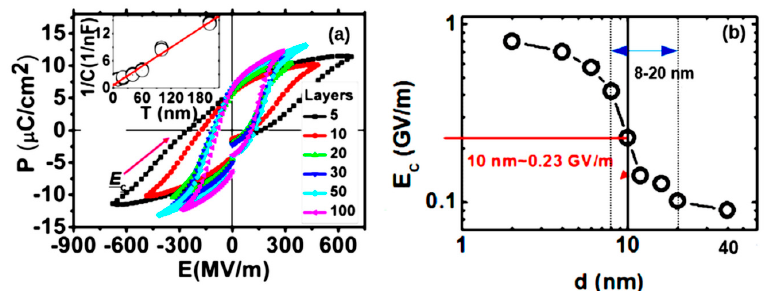
Figure 4. Hysteresis loops of the LB PVDF film [16]: ( a ) with different numbers of monolayers: 5, 10, 20, 30, 50 and 100 (the inset shows the linearity of the reciprocal capacity depending on the thickness); ( b ) E C as a function of the LB thickness of the PVDF film (with the transition region at 8–20 nm). Reproduced with permission from [16]; AIP Publishing, 2014. Another method for obtaining a coercive field is by calculation of hysteresis loops P ( E ) [27,28]. Calculations performed for different numbers of chains and film thicknesses using both these methods showed that the dependence of the obtained coercive field [18,19,28] is in good agreement with the experimentally established dependence of the coercive field E C on the film thickness [16] (Figure 5).